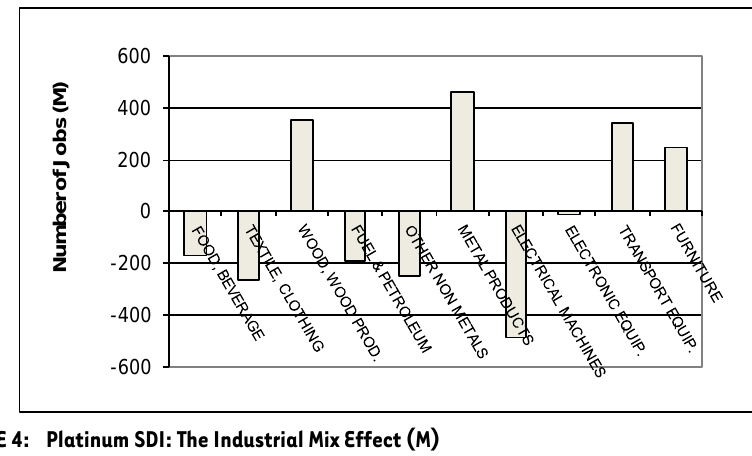
FIGURE 4: Platinum SDI: The Industrial Mix Effect (M)